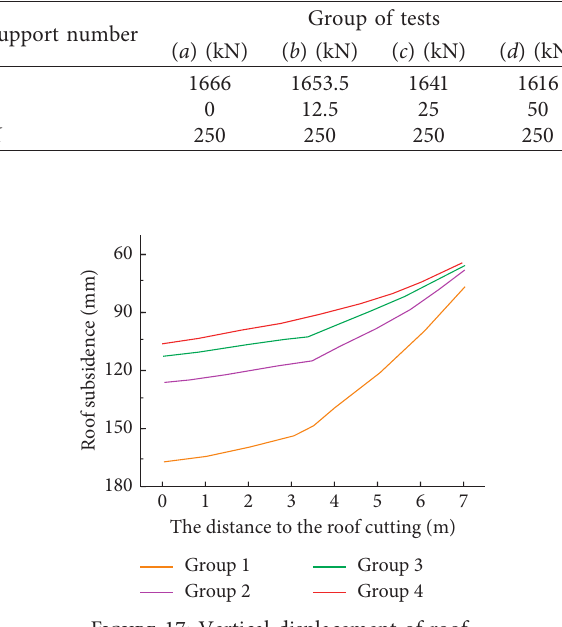
Figure 16: Fracture development in surrounding rock (the pink line represents the open cracks and the blue line stands for the slip cracks): Table 5: Maximum support force in each group of tests.